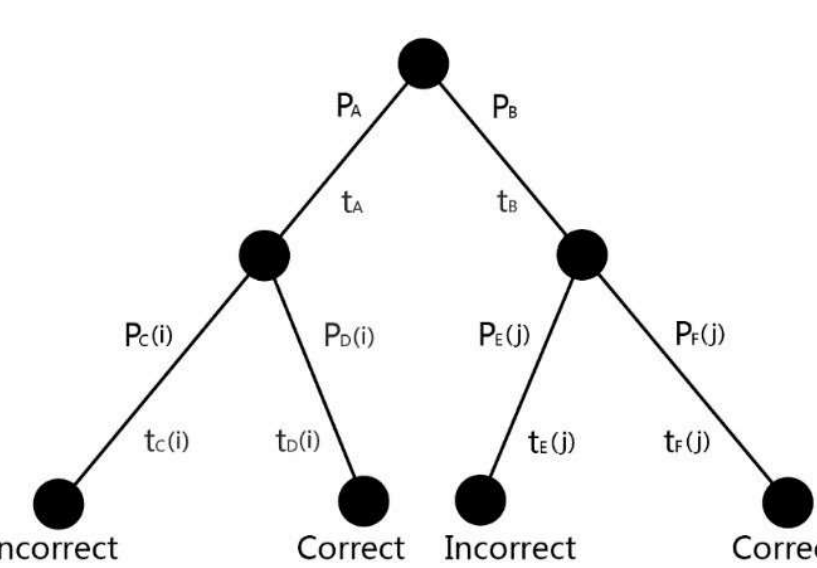
Figure 3. The Standard Tree for Unordered Processes.